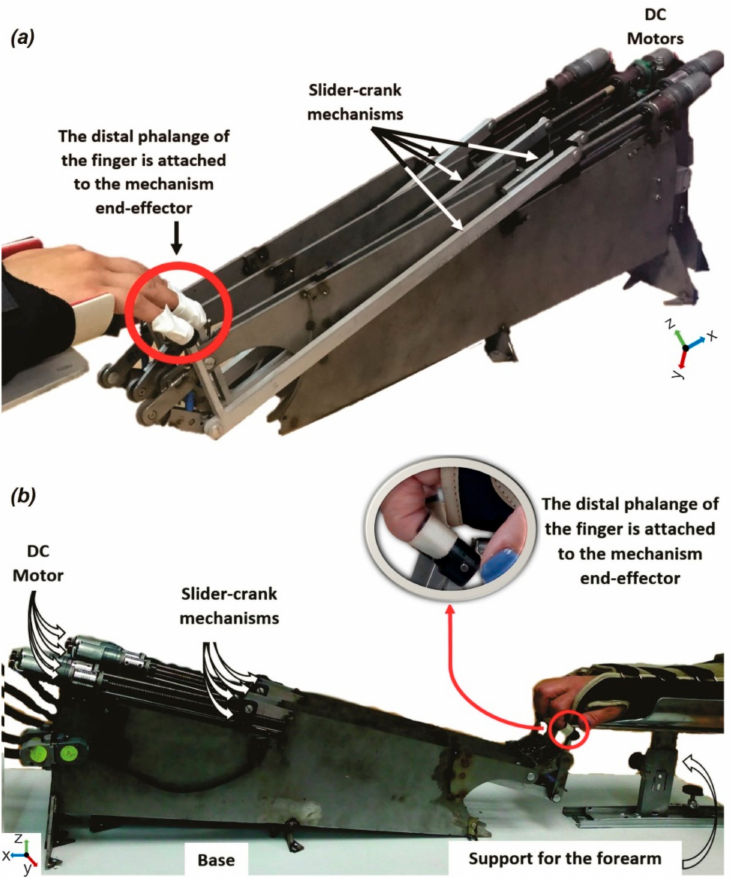
Figure 4. Finger rehabilitation prototype: ( a ) isometric view; ( b ) front